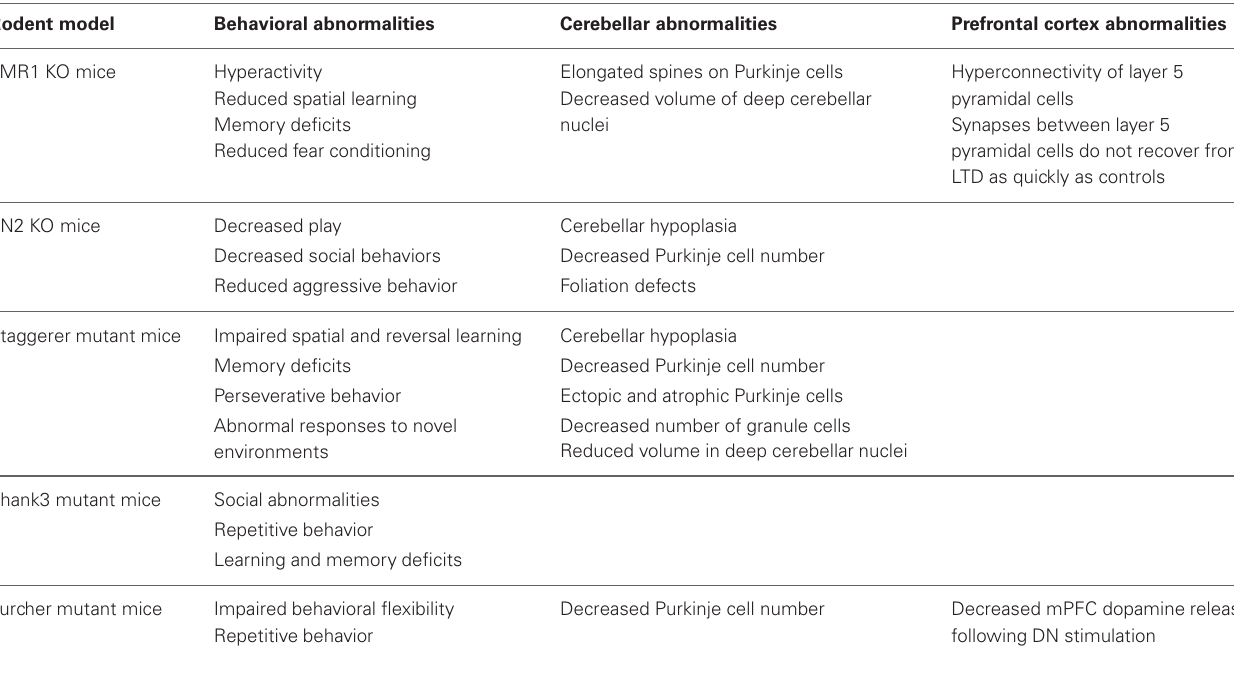
Table 1 | Summary of genetic rodent models with cerebellar and behavioral abnormalities that parallel those observed in autism. Rodent